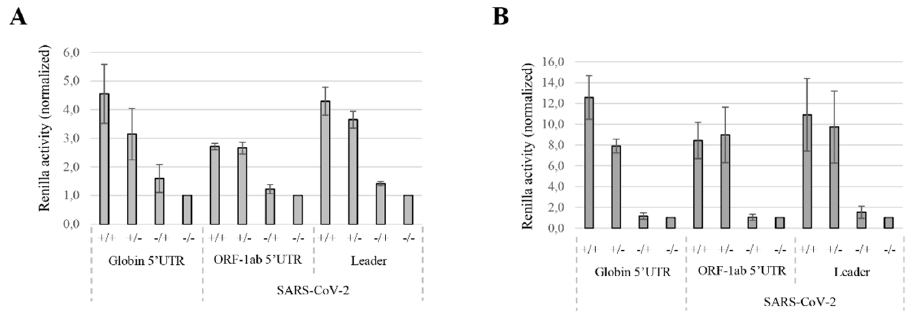
Figure 5. The effects of the cap and poly(A) tail on viral translation. Capped/polyadenylated (+/+), capped/non-polyadenylated (+/ − ), uncapped/polyadenylated ( − /+) or uncapped/non-polyadenylated ( − / − ) Globin Renilla, 5 ′ UTR ORF1ab Renilla and leader Renilla RNAs were translated in ( A ) the RRL or in ( B ) the untreated RRL. Translational products were analyzed by luciferase assays and normalized to the ( − / − ) condition (arbitrary set at 1). Values shown are the mean +/ − S.D. for three independent experiments.